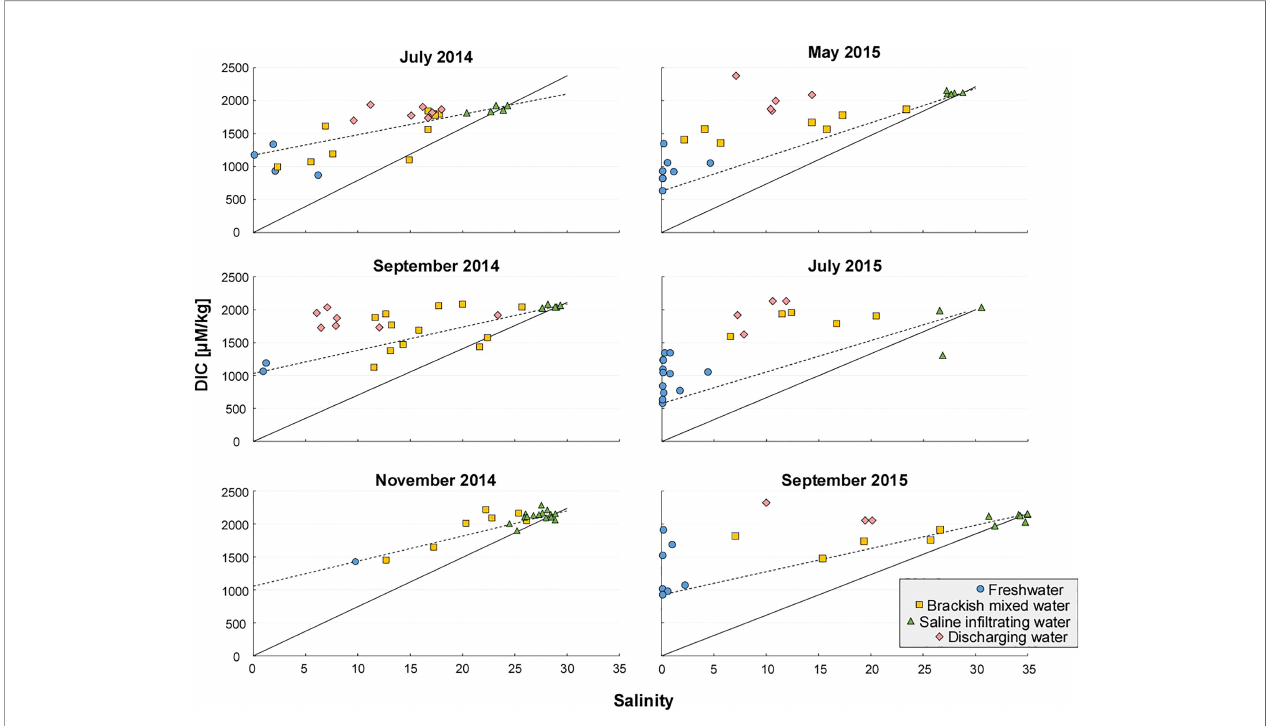
FIGURE 3 | Salinity vs. DIC. The theoreticaldilution line assumingfreshwater DIC = 0 isshownas a solid line, and assuminga freshwater DIC endmember from the lowest- salinity sample shownas a dotted line. Greatest production was measured insamples within the discharging water (pink symbols). See Supporting Information for sample grouping method that utilized cellgeometryand salinity (November 2014 prioritizedcellgeometryin sample grouping due to a broad saline